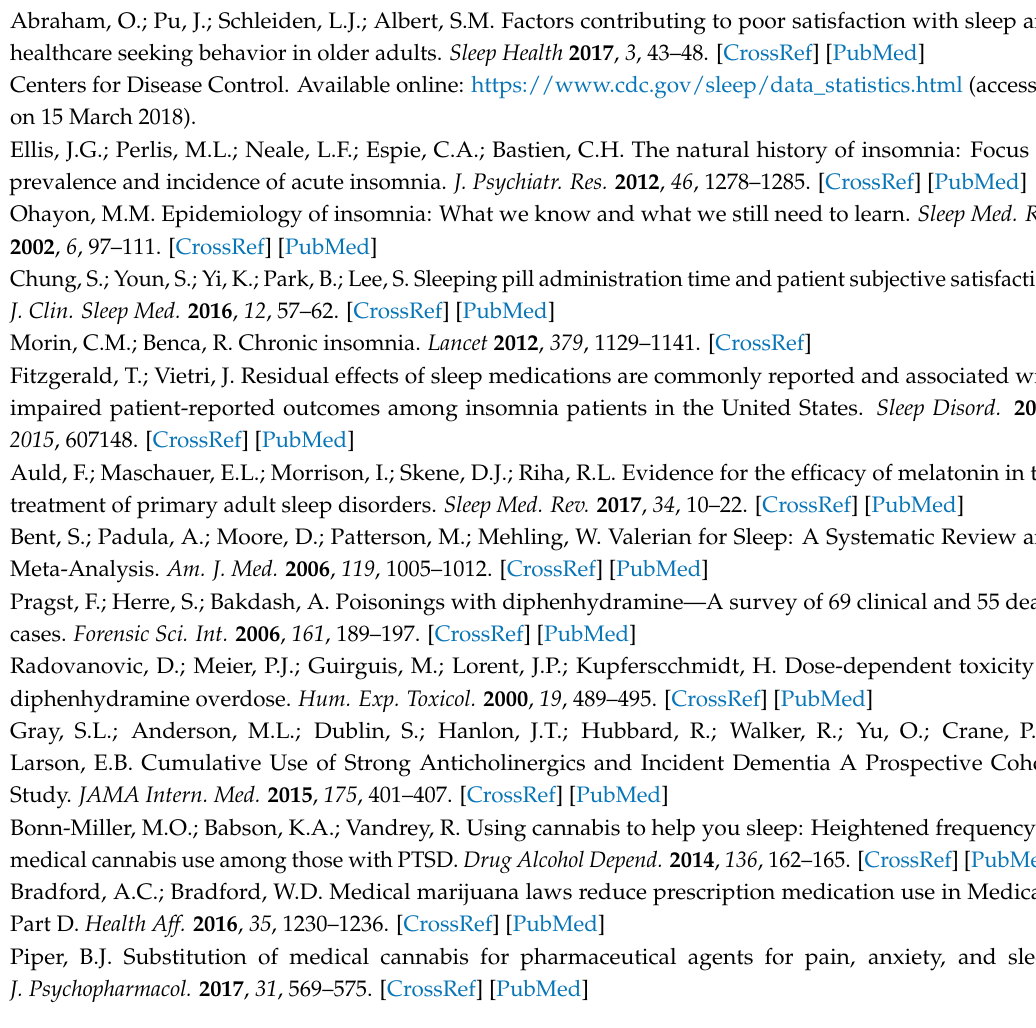
Table S1: Categories and Frequency of Side Effect Reporting, Figure S1: Releaf App TM User